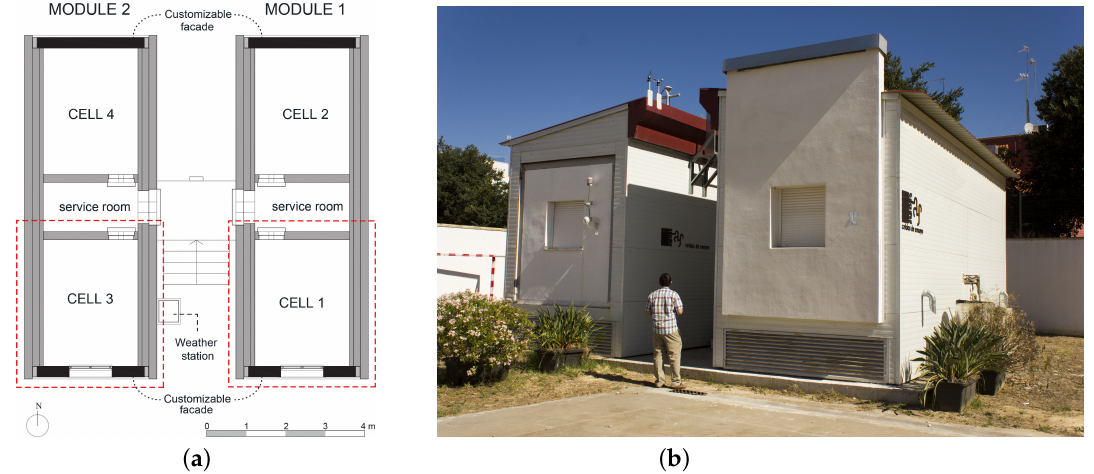
Figure 2. ( a ) Floor plan of the test cells; ( b ) external view of Cell 1 with the OVF ( right ) and Cell 3 with the UVF ( left